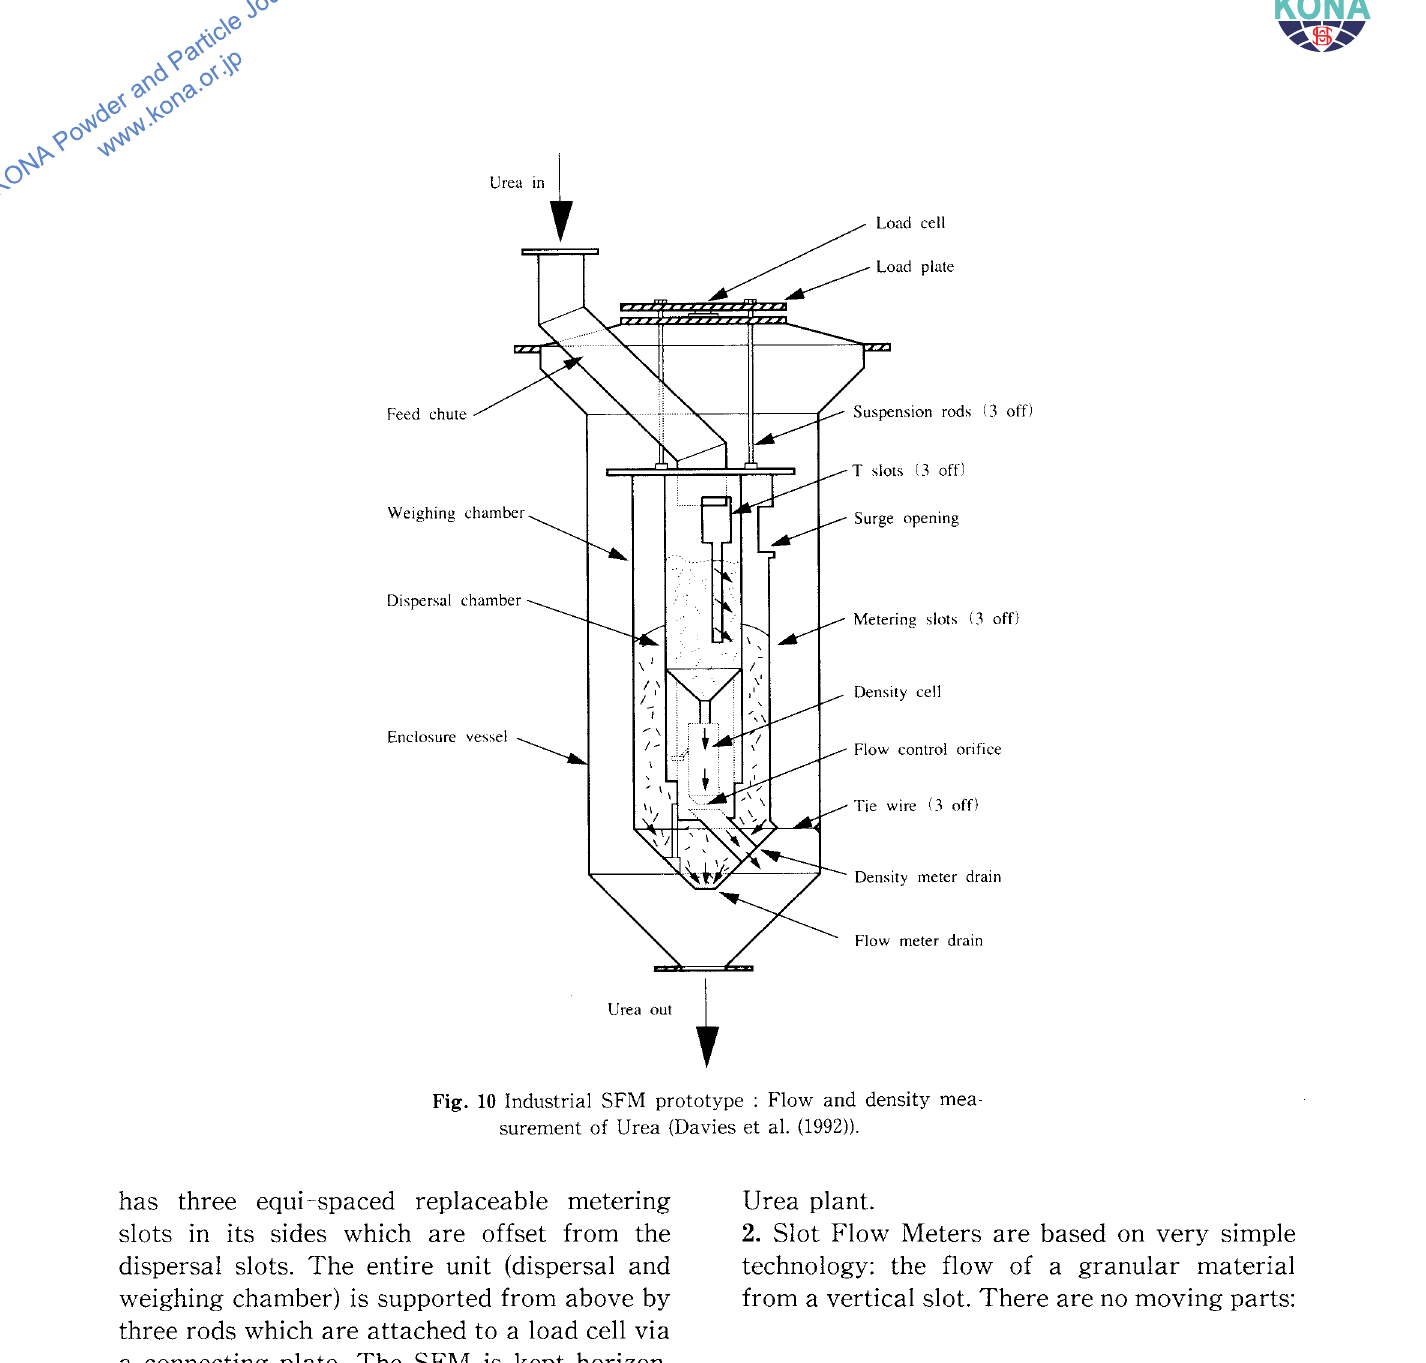
Fig. 10 Industrial SFM prototype : Flow and density mea